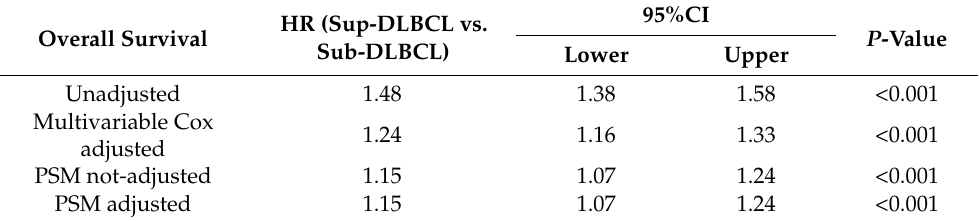
Table 5. Cox proportional hazards model for overall survival in patients with early-stage nodal diffuse large B-cell lymphoma: Only the meaningful factors in the univariate analysis are included in the multivariate